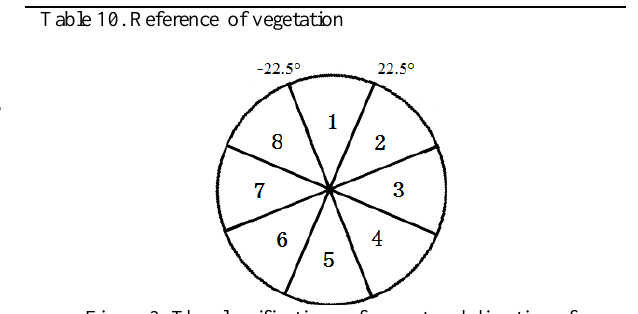
Table 10. Reference of vegetation